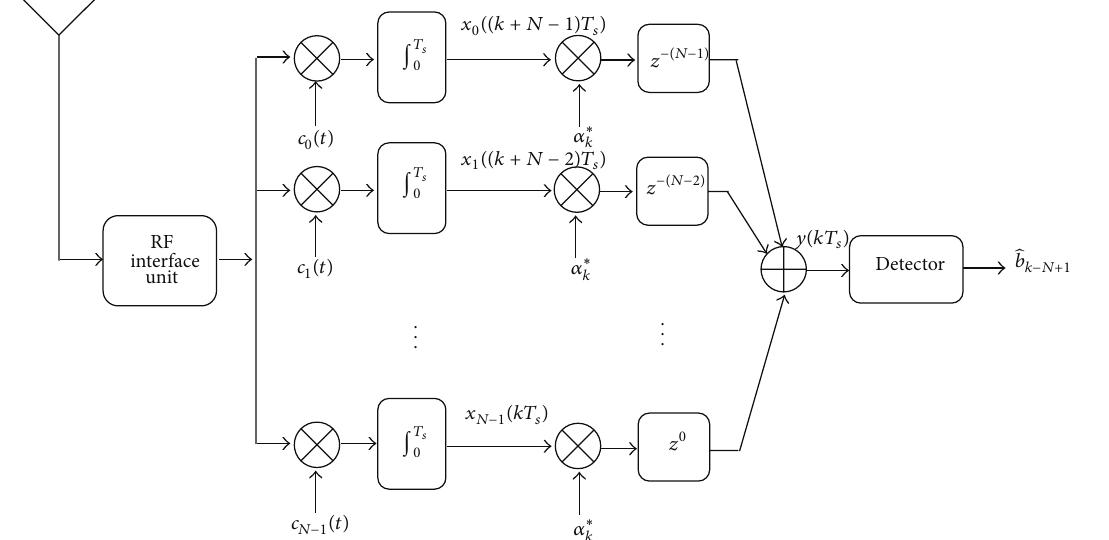
Figure 3: The code-time diversity DSSS receiver in Rayleigh flat fading